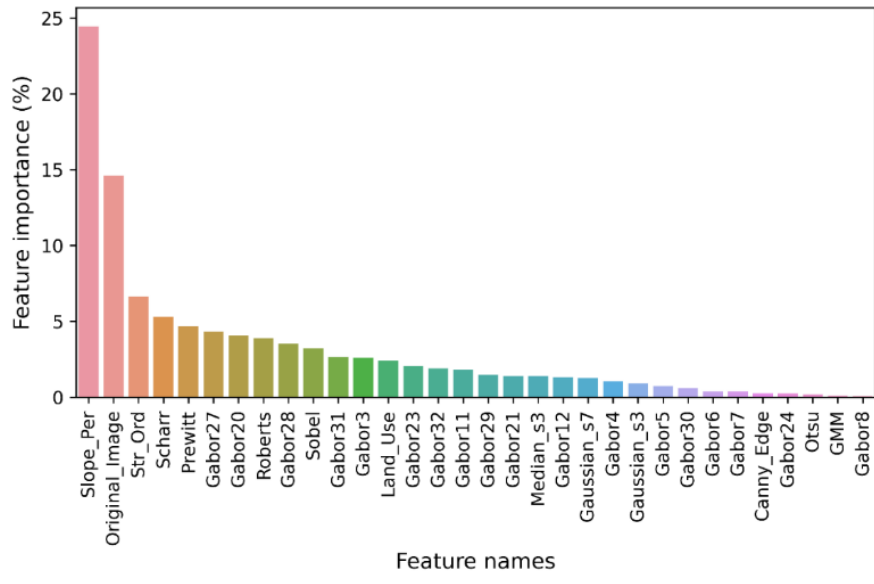
Figure 12. Input feature importance.